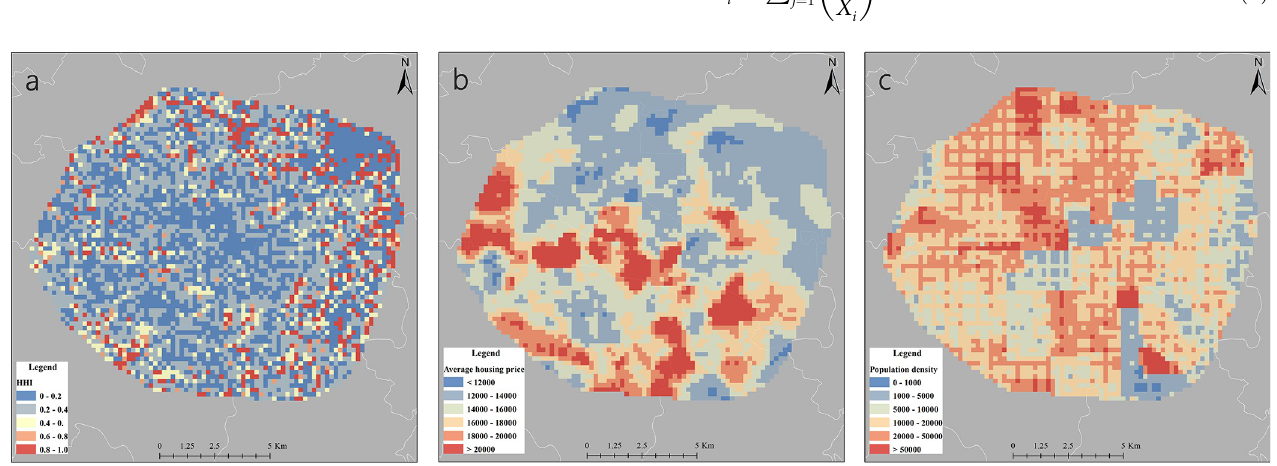
Fig 3. The typical distributions of HHI, average housing price and population density. a: HHI; b: average housing price; c: population density. (https:// www.openstreetmap.org/copyright).